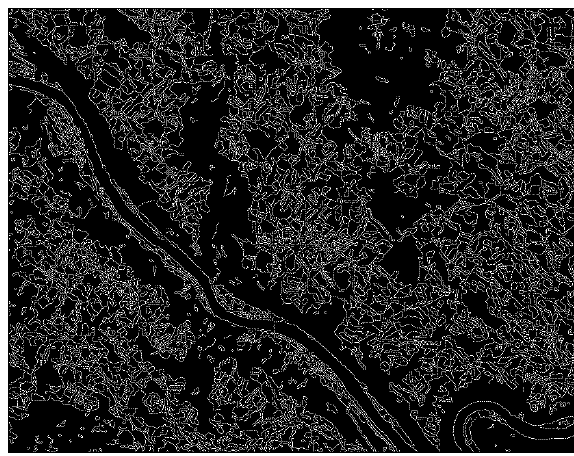
Figure 2. Edge detection in an orthophoto image; image covers the area of 13 km × 10